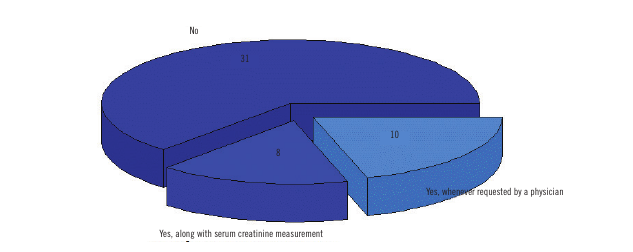
Figure 2 − eGFR reporting eGFR: estimated glomerular filtration rate.